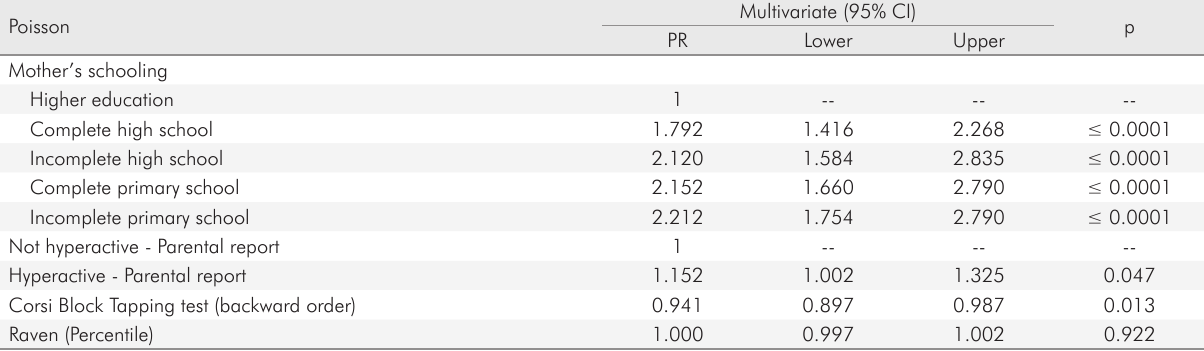
Table 6. Multivariate Poisson regression considering occurrence of cavitated teeth as dependent variable and socio-demographic characteristics, parental reports of hyperactivity, and executive functions as independent